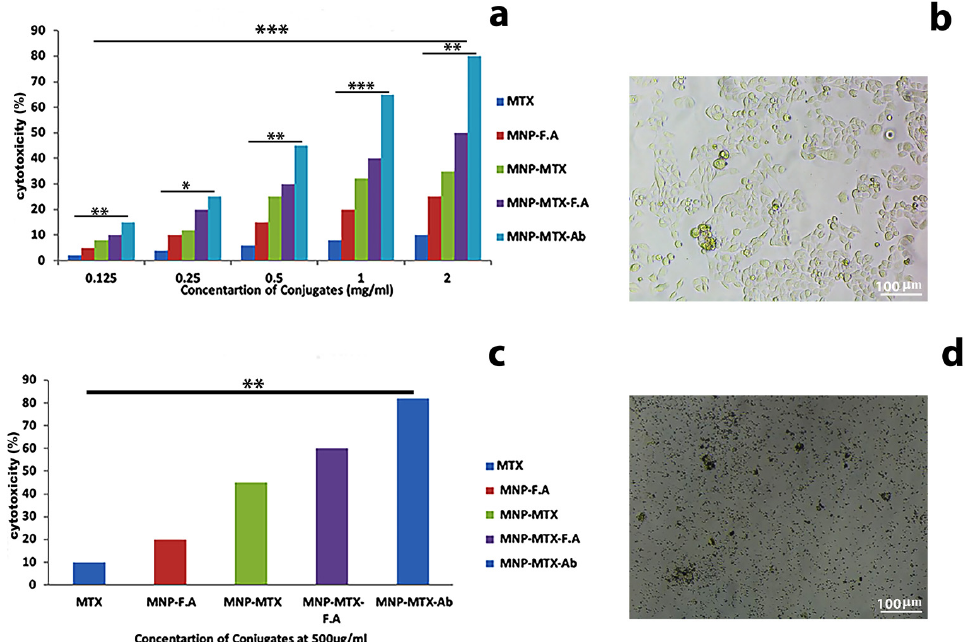
Figure 6. Cytotoxic effects of different conjugates to HeLa cells and MTT assay. Data represents in the form of mean (n=3) ± SD with p value <0.0001 (***), <0.001 (**) and <0.01 (*). ( a ) Graph shows the percentage of cell cytotoxicity of different concentrations of nanocomposites. ( b ) Control (HeLa cells) showing cell growth in the absence of nanomedicines. ( c ) The cytotoxic effects through antibody-mediated endocytosis of different nanocomposites. ( d ) Test cells with conjugate MNP-MTX-FR Ab.